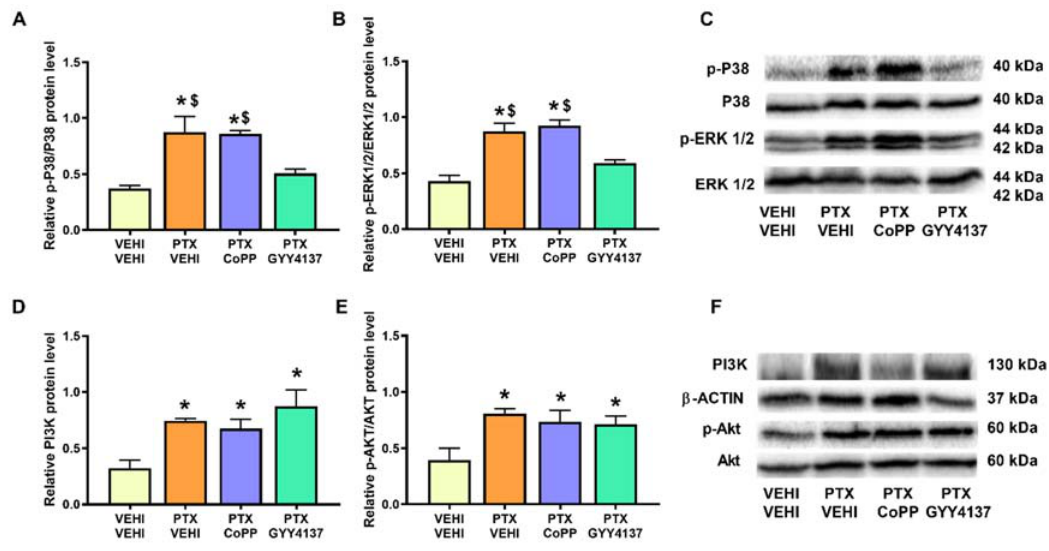
Figure 7. Effects of CoPP and GYY4137 on the expression of p-P38, p-ERK 1/2, PI3K, and p-Akt in the DRG of PTX-injected mice. The graphs represent the protein levels of p-P38/P38 ( A ), p-ERK 1/2/ERK 1/2 ( B ), PI3K ( D ), and p-Akt/Akt ( E ) in the DRG of PTX-injected mice treated with CoPP or GYY4137. The control group treated with VEHI–VEHI is also shown. Representative blots for p-P38, P38, p-ERK 1/2, and ERK 1/2 ( C ) and for PI3K, β -actin, p-Akt, and Akt ( F ) are displayed. In all panels, * indicates significant differences vs. the VEHI–VEHI-treated mice, and $, vs. PTX-injected mice treated with GYY4137 ( p < 0.05, one-way ANOVA followed by the SNK post hoc test). Data are expressed as mean values ± SEM; n = 3 samples per group.